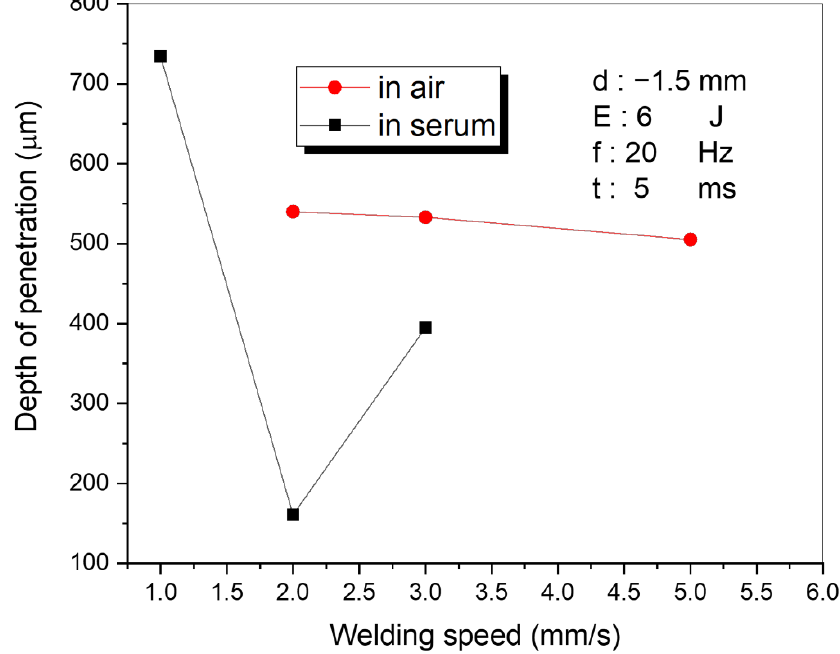
Figure 2. The relationship between the welding speed and the penetration depth. The focal position of the laser beam may affect the laser-welding performance. The laser-welding process was performed with four different focal positions while other pa- rameters were kept constant: 5 mm/s speed, 11 J energy, 20 Hz frequency, and 5 ms pulse duration. The change in penetration depth with various focal positions of the laser is shown in Figure 3. The penetration depth decreased significantly when the focal point distance increased from the welding surface, shown in Figure 3. When the focal point was far from the surface, the spot size of the laser increased as seen in Figure 3, which means the number of photons per unit area was lower. In addition, the penetration depth in air welding